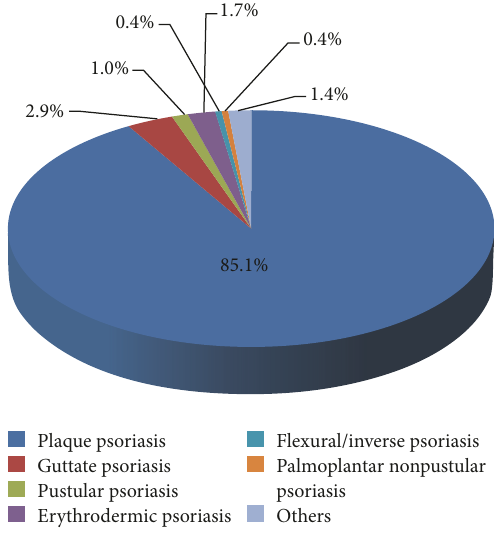
Figure 1: Type of